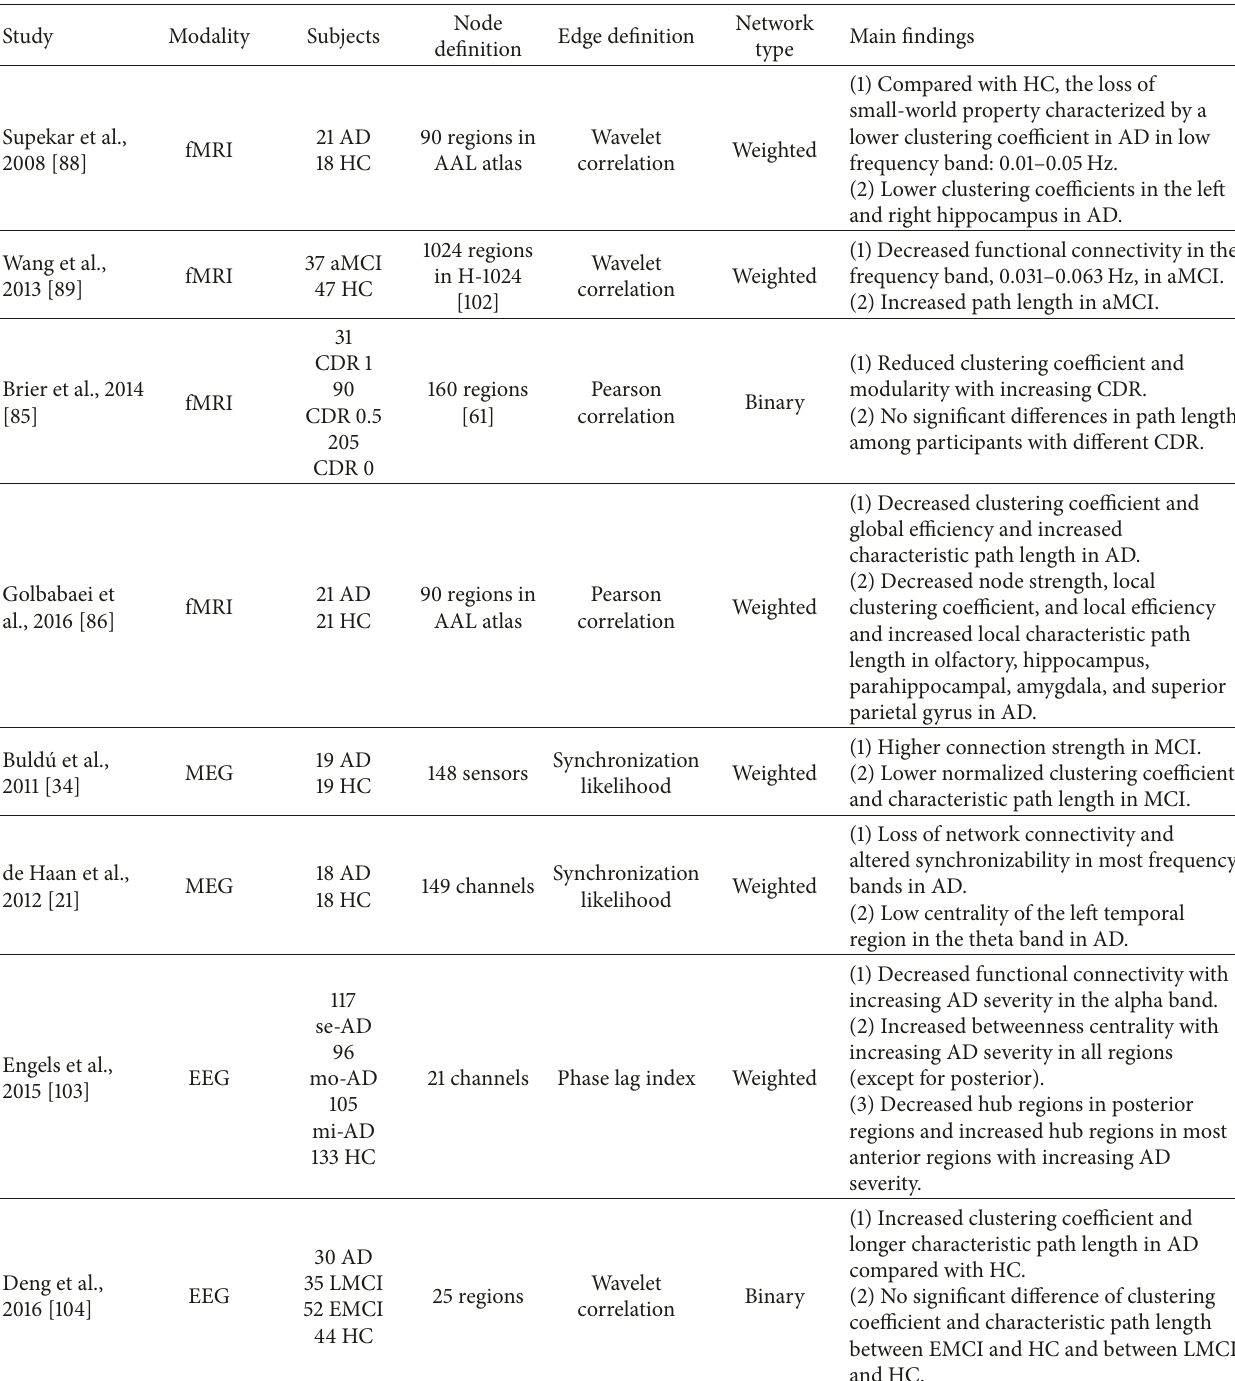
Table 3: Overview of functional brain network studies in